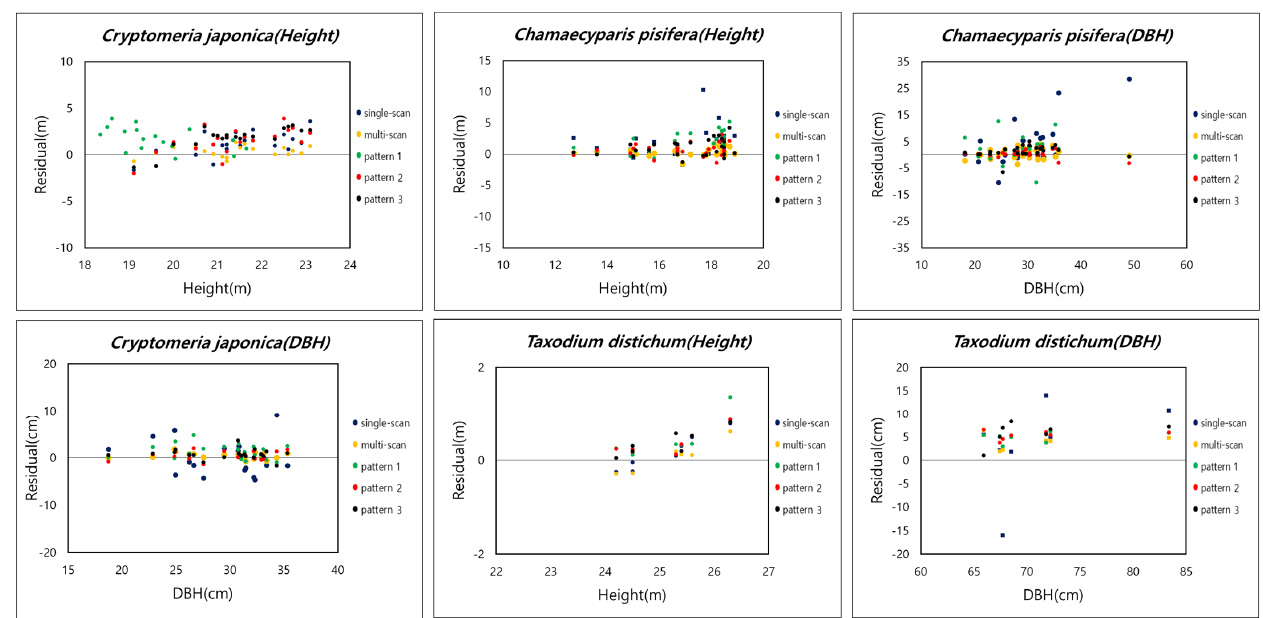
Figure 8. Comparison of the residual errors for height and DBH class using the TLS and BPLS.